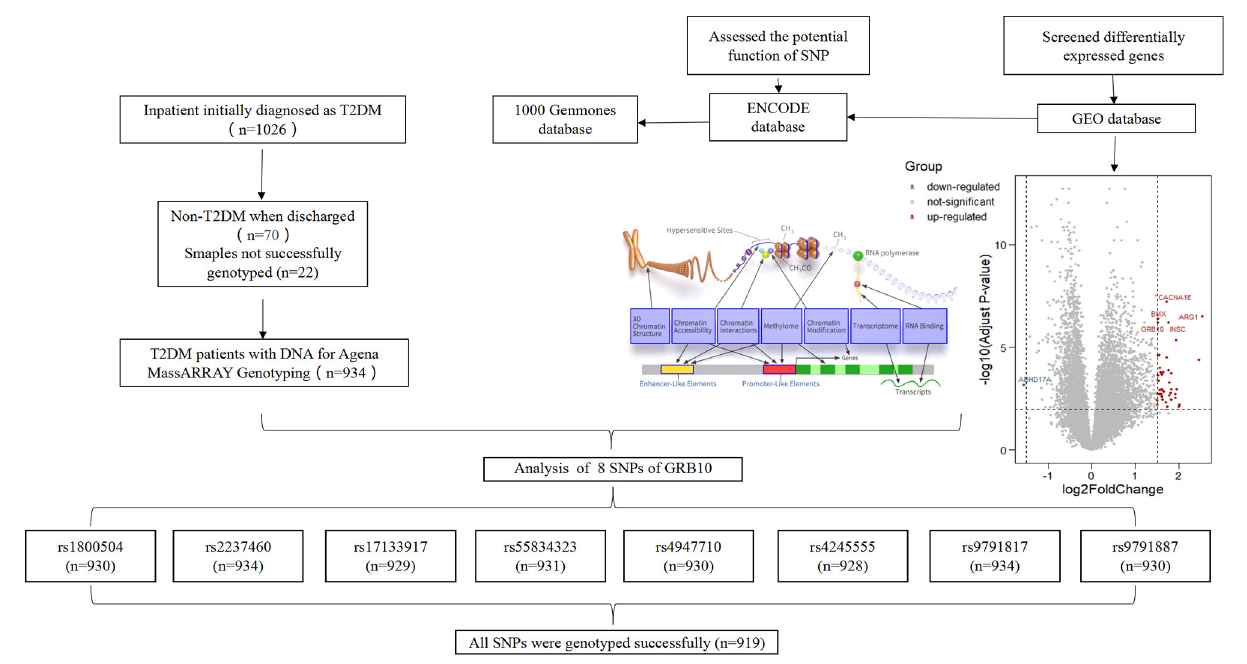
FIGURE 1 | Flow chart showing the research